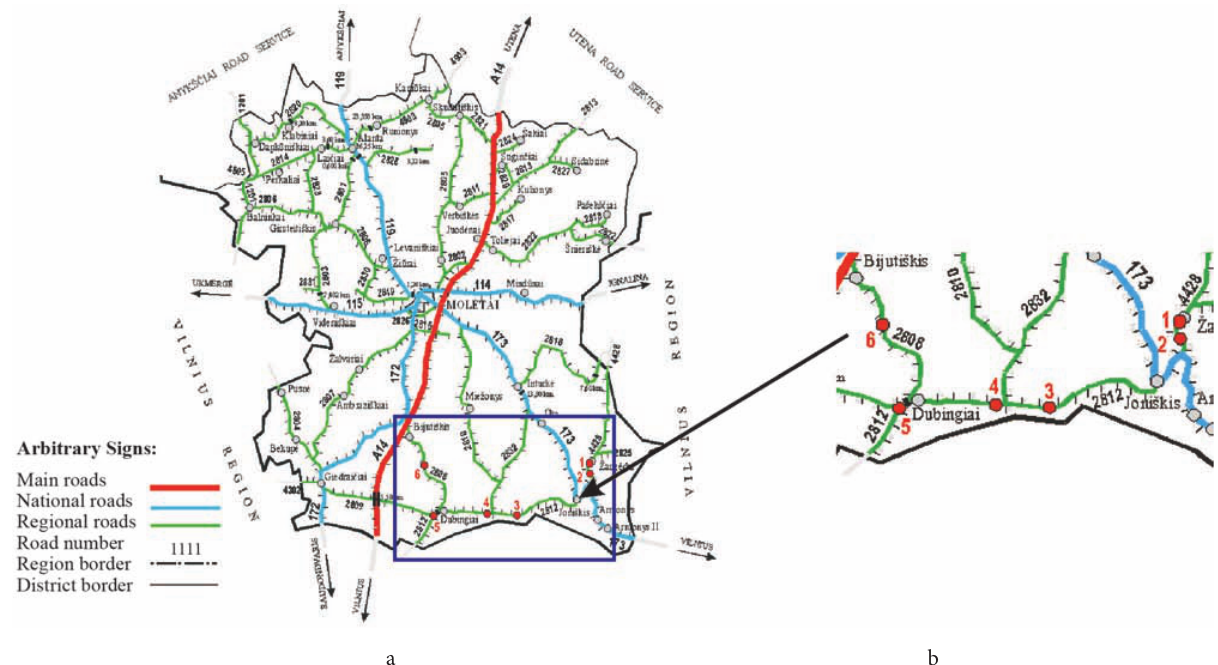
Fig. 2. Noise level measurement points: a – network of roads of national signifi cance of Molėtai district (the rectangle indicates the road sectors researched); b – the confi guration of the roads researched (1 to 6 – measurement